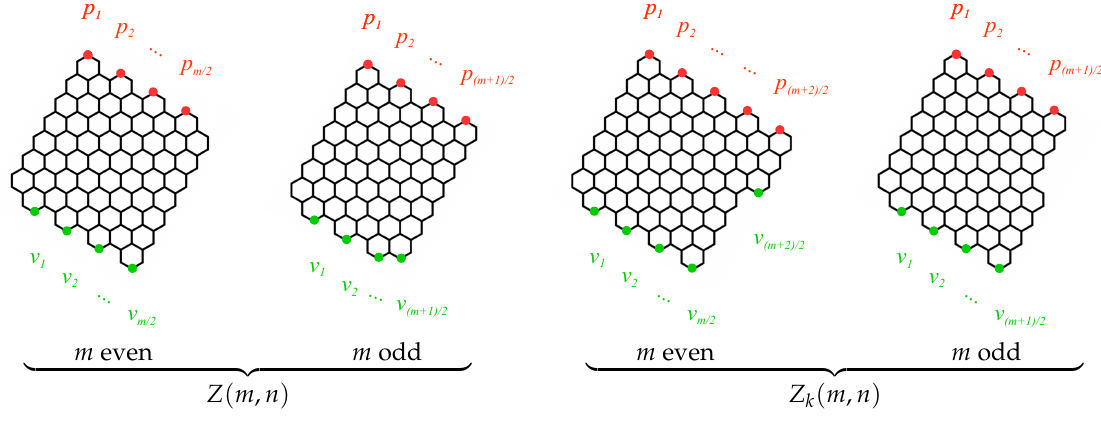
Figure 3. The preferred orientation of the benzenoids Z ( m , n ) and Z k ( m , n ) allowing to define the optimal sets of peaks p i and valleys v j .